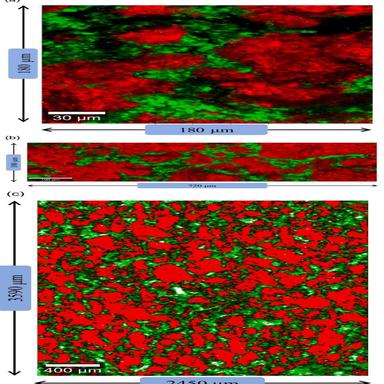
(A) Raman Chemical Imaging of Formulated Tablets (Run 1), Legend API (Green), Sorbitol (Red). (B) Raman Chemical Imaging of Formulated Tablets (Run 2), Legend API (Green), Sorbitol (Red). (C) Raman Chemical Imaging of Formulated Tablets (Run 3), Legend API (Green), Sorbitol (Red).